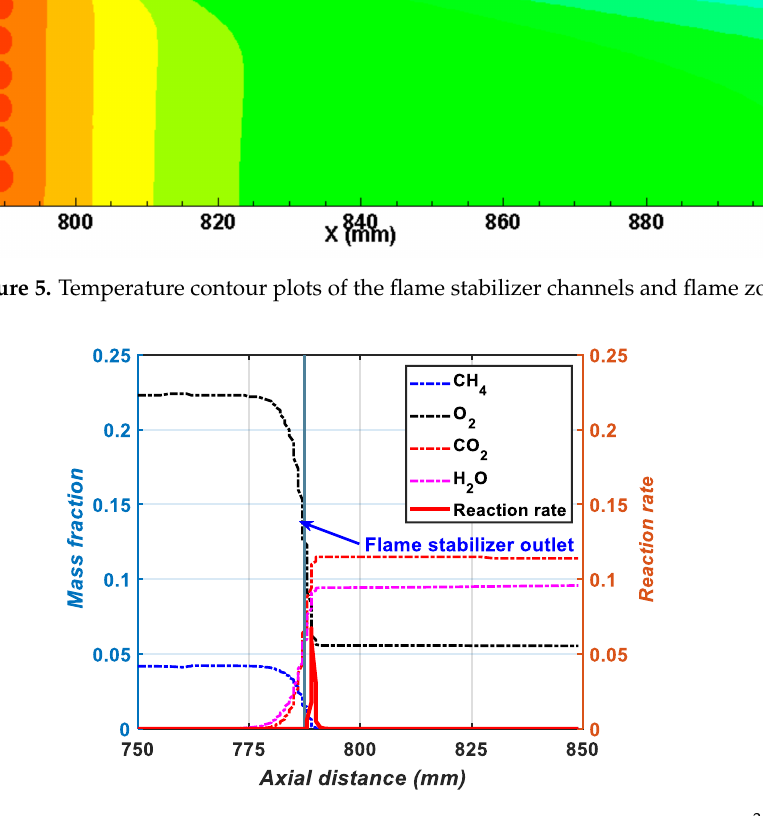
Figure 6. Species mass fraction distribution and reaction rate [kmol/m 3 ·s] along the centerline.